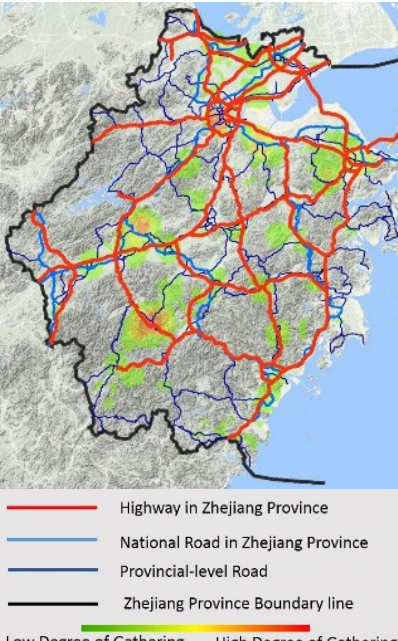
Figure 10 . The Gathering Map of Cultural Resource Density and Traffic Distribution